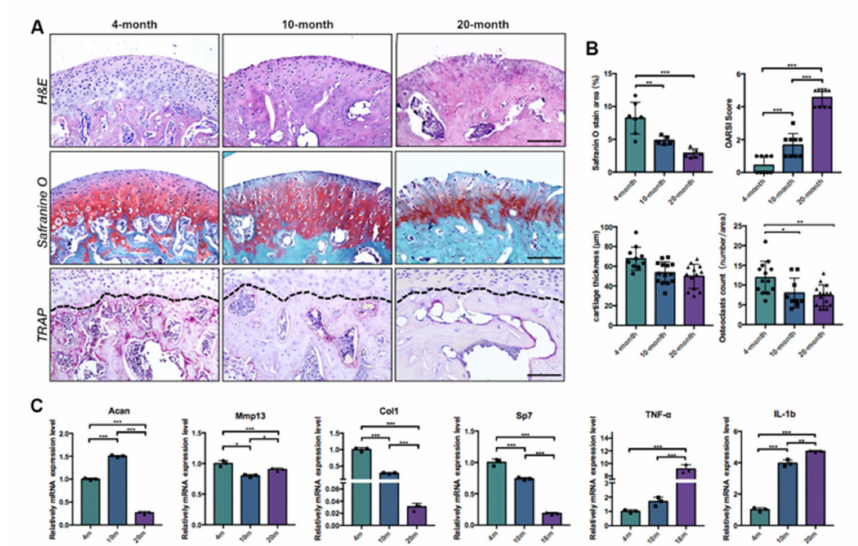
Figure 2. Cartilage degeneration and subchondral bone remodeling decreased in aged TMJ condyle. ( A ) H&E, Safranin O and TRAP staining sagittal sections of the 4-month-old, 10-month-old, and 20-month-old TMJ condyles. Scale bar: 50 µ m. The black dotted lines indicated the osteochondral interface of TMJ condyles. ( B ) Quantitative analyses of cartilage thickness, safranin O staining area, OARSI score in safranin O staining sections, and osteoclast counts in TRAP staining sections. ( n > 6) * p < 0.05, ** p < 0.01, *** p < 0.001. ( C ) qRT-PCR analyses of the mRNA expression of Acan, MMP13, Col I, Sp7, TNF- α , and IL- β of TMJ condyles in different age groups. * p < 0.05, ** p < 0.01, *** p <